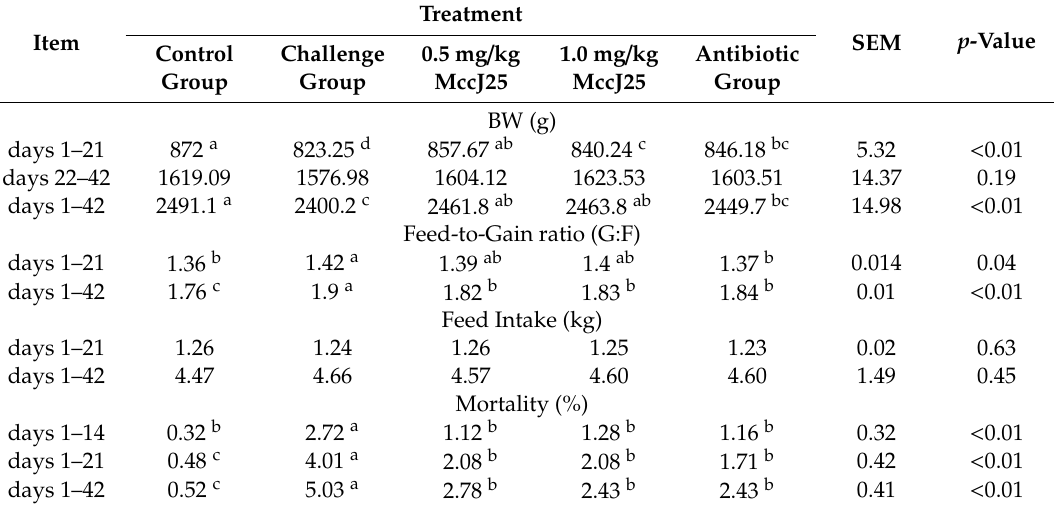
Table 3. E ff ects of MccJ25 on performance of broilers under E. coli. and Salmonella infection 1